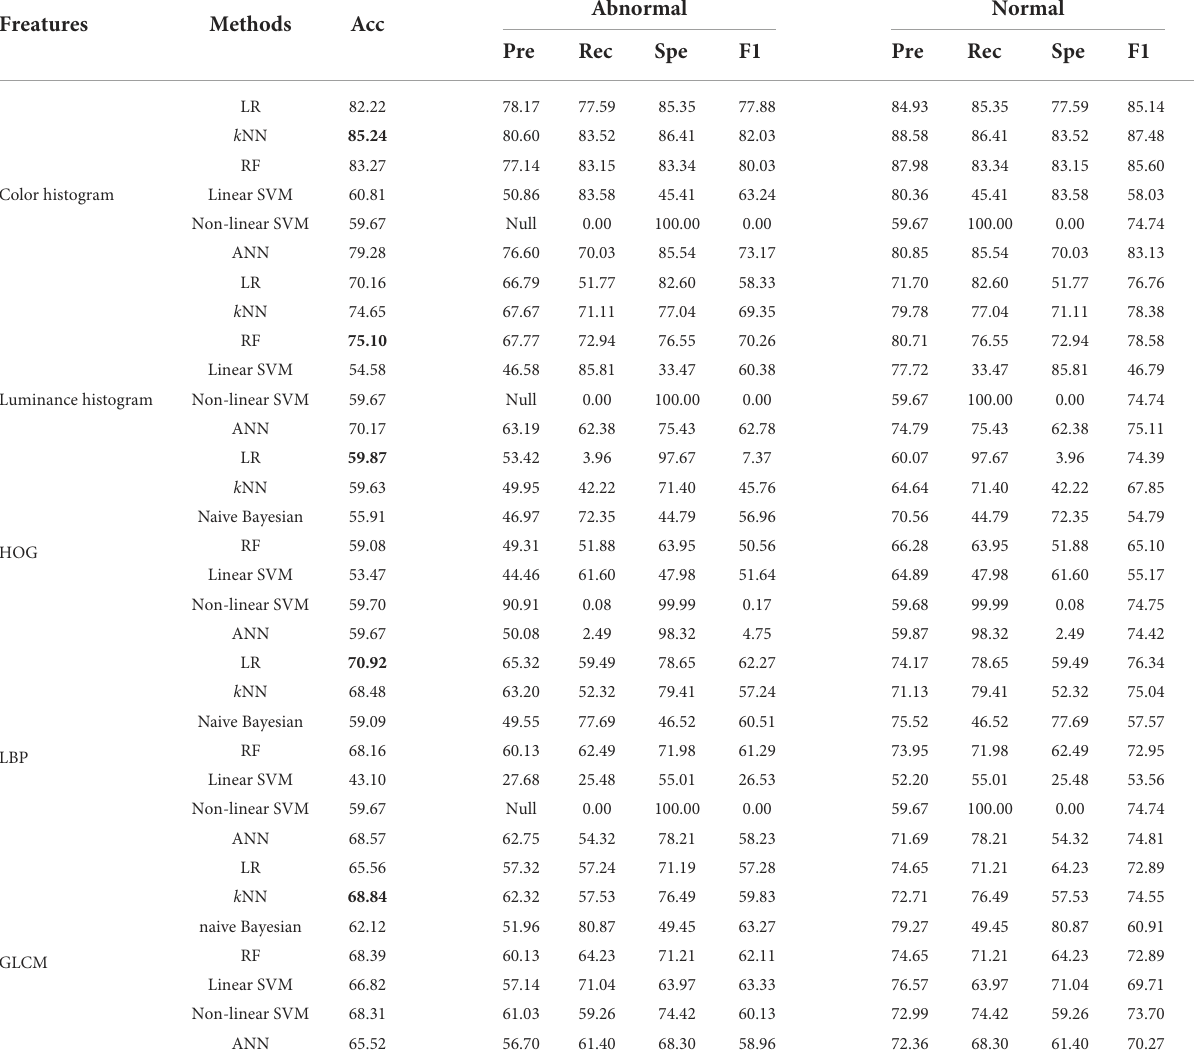
TABLE 5 Classification results of five image features using different classifiers in the 80 × 80 pixels sub-database of GasHisSDB [In (%)].